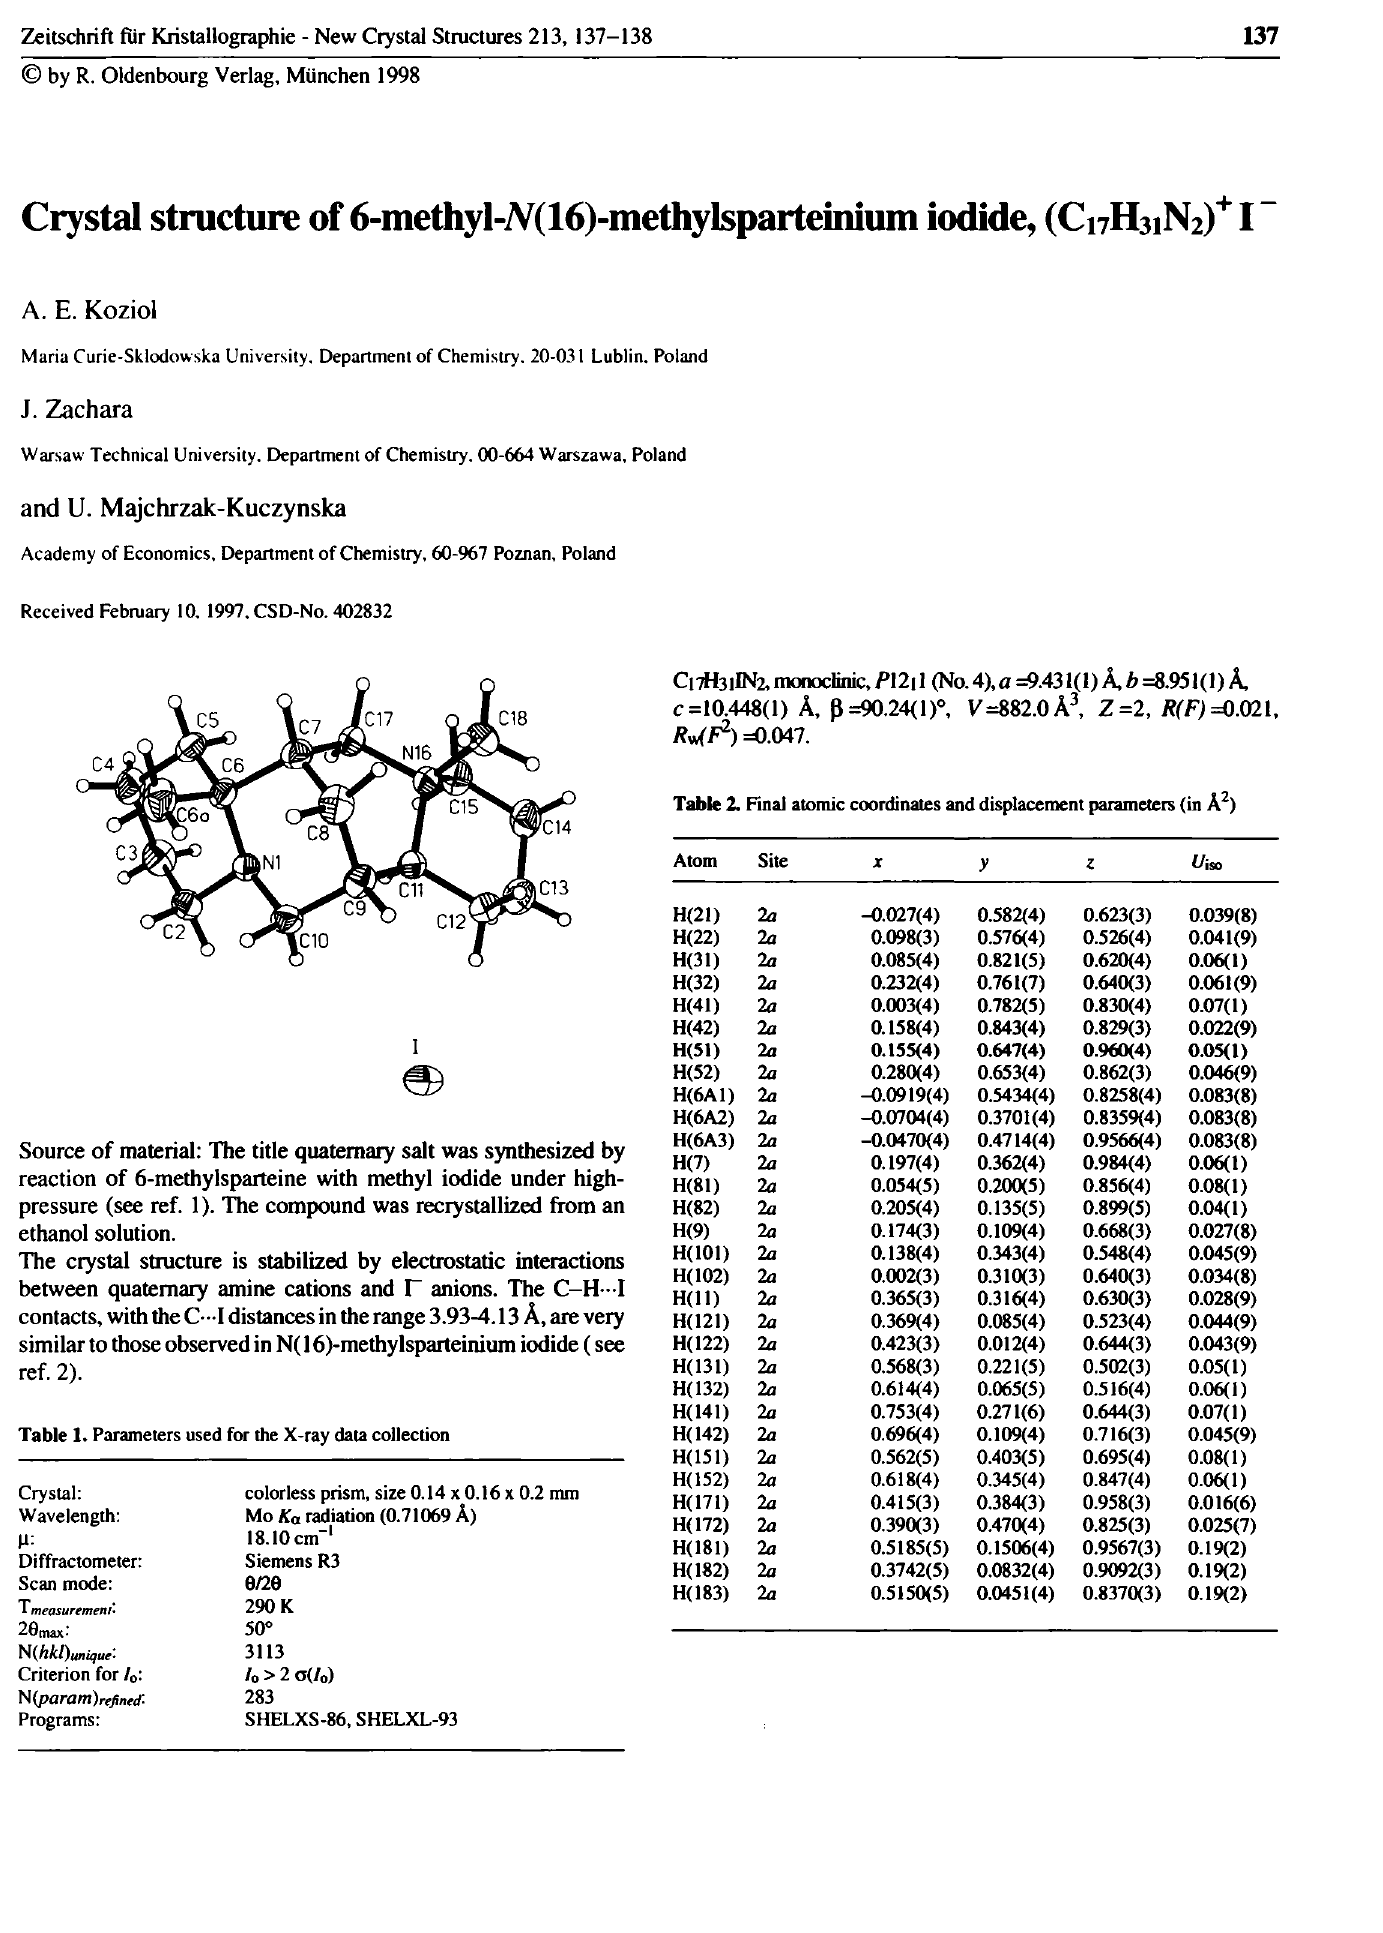
Table 2. Final atomic coordinates and displacement parameters (in